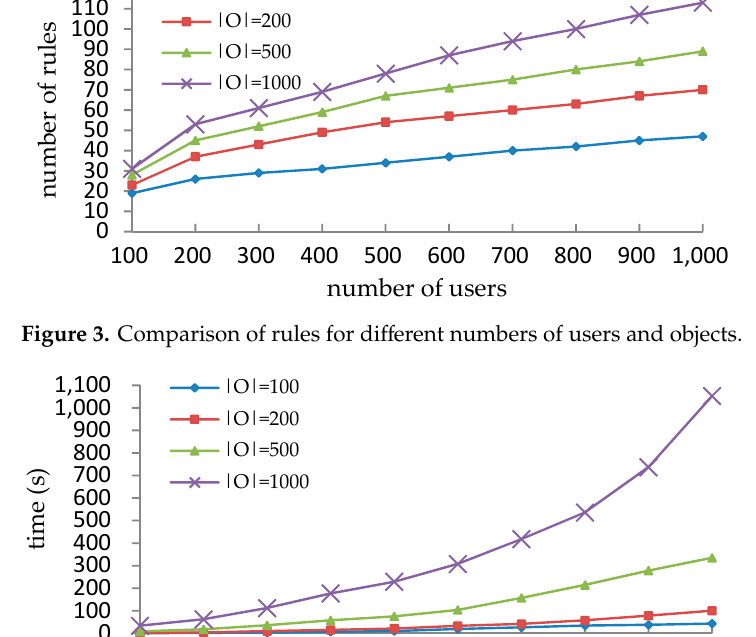
ff erent numbers of users and Figure 4. Comparison of time for different numbers of users and objects. Figure 4. Comparison of time for di